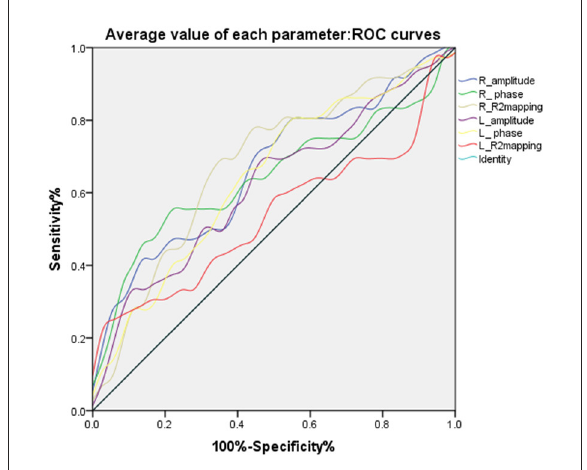
FIGURE4 ROC curves of the average values of different parameters in bilateral substantia nigra compact zone.